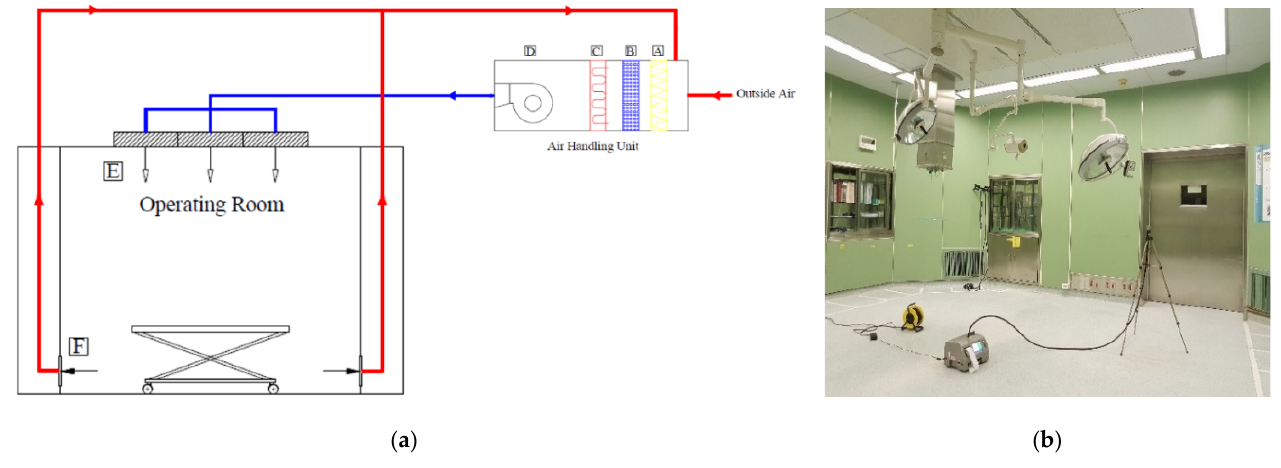
Figure 1. The investigated operating room: ( a ) HVAC system; ( b ) snapshot.